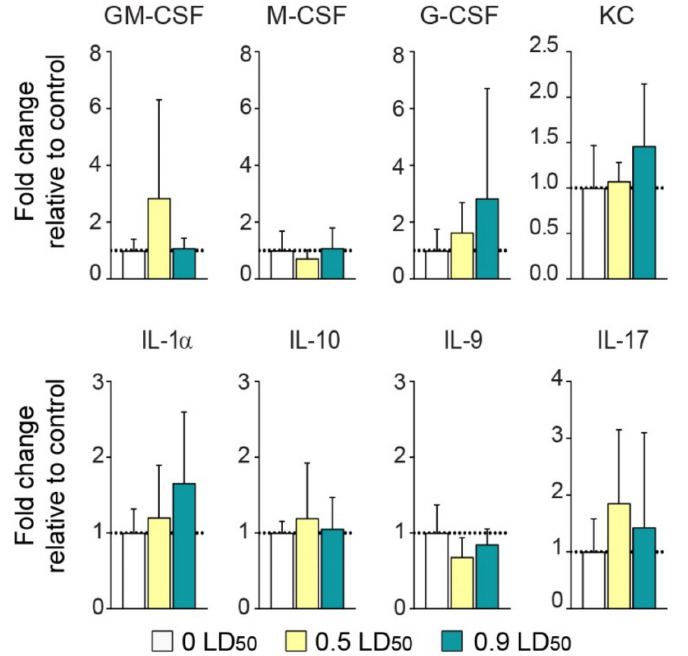
Figure 6. NIMP does not induce long-term systemic inflammation. Expression levels of the serum cytokines GM-CSF, M-CSF, G-CSF, KC, IL-1 α , IL-10, IL-9 and IL-17 normalized to CTL values at 6 months post-intoxication [(GM-CSF: 1.0 ± 0.2 for 0 LD50; 2.8 ± 0.13 for 0.5 LD50 and 1.1 ± 0.01 for 0.9 LD50); (M-CSF: 1.0 ± 0.3 for 0 LD50; 0.72 ± 0.10 for 0.5 LD50 and 1.08 ± 0.3 for 0.9 LD50); (G-CSF: 1.0 ± 0.3 for 0 LD50; 1.63 ± 0.4 for 0.5 LD50 and 2.8 ± 1.46 for 0.9 LD50); (KC: 1.0 ± 0.2 for 0 LD50; 1.1 ± 0.08 for 0.5 LD50 and 1.46 ± 0.2 for 0.9 LD50); (IL-1 α : 1.0 ± 0.1 for 0 LD50; 1.2 ± 0.3 for 0.5 LD50 and 1.7 ± 0.4 for 0.9 LD50); (IL-1 α : 1.0 ± 0.07 for 0 LD50; 1.2 ± 0.3 for 0.5 LD50 and 1.06 ± 0.2 for 0.9 LD50); (IL-9: 1.0 ± 0.2 for 0 LD50; 0.68 ± 0.1 for 0.5 LD50 and 0.85 ± 0.07 for 0.9 LD50); (IL-17: 1.0 ± 0.3 for 0 LD50; 1.86 ± 0.6 for 0.5 LD50 and 1.43 ± 0.6 for 0.9 LD50)]. Statistical analyses were conducted by one-way ANOVA ( n = 8 per